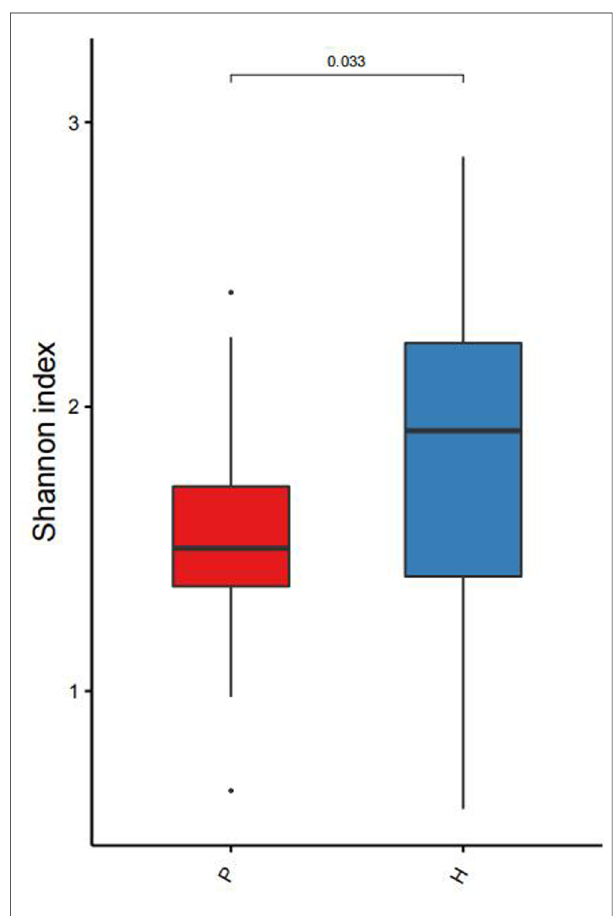
FIGURE 1 Chart showing comparison of microbiota diversity between the two